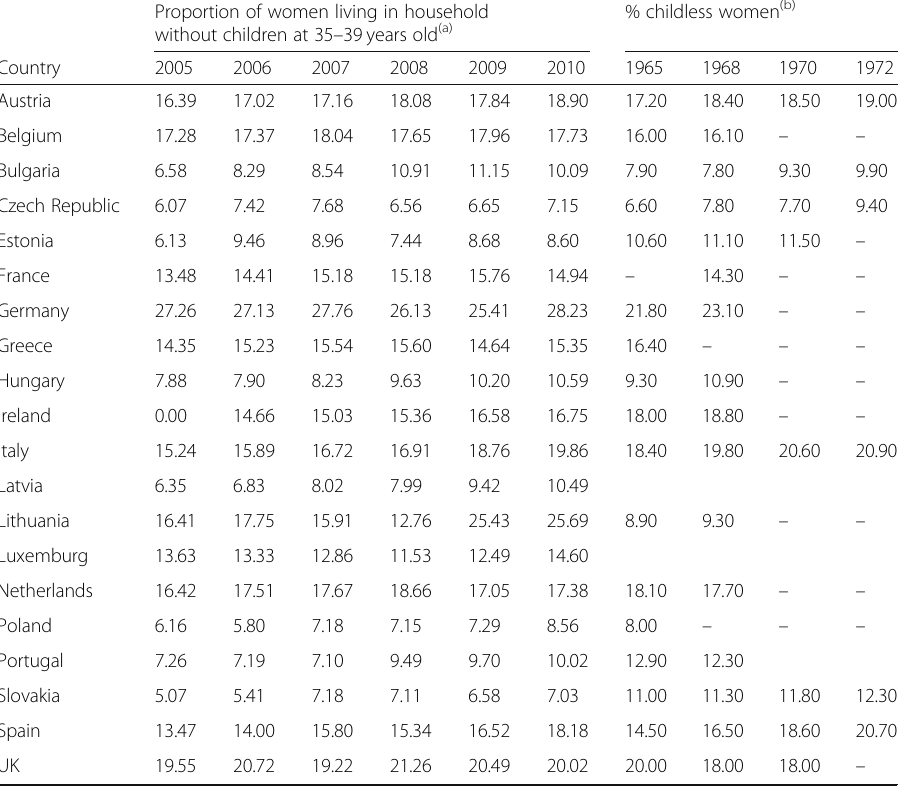
Table 4 The proportion of women aged 35 – 39 without cohabiting children slightly